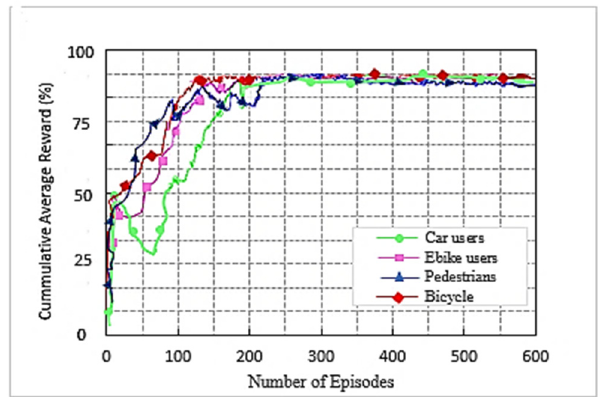
Figure 8. Cumulative reward as a function of the number of training episodes for our proposed JMLS–DDPG HO scheme according to user type.